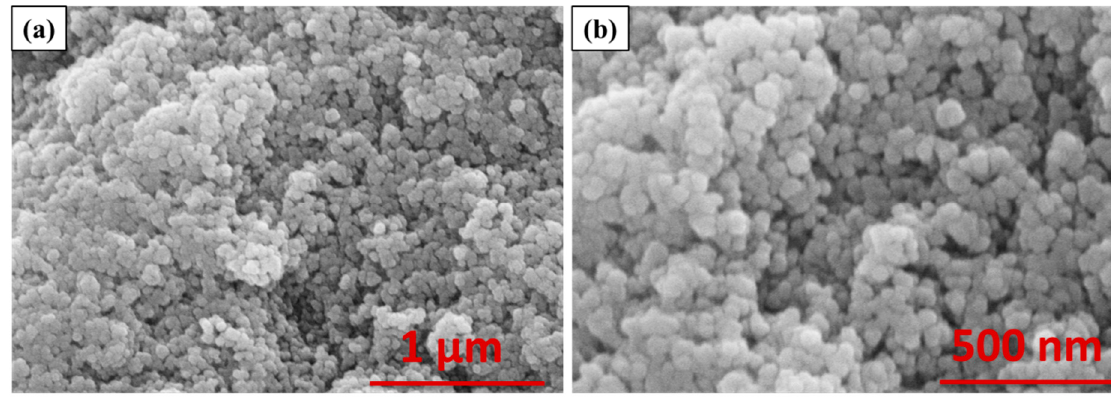
Figure 2. ( a , b ) FE-SEM images of NiO.